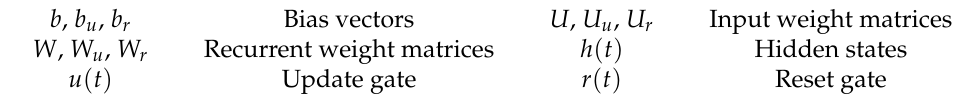
Table 1. GRU model